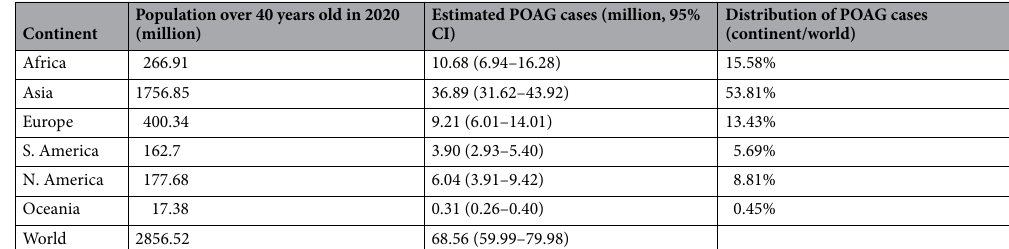
Table 2. Estimated global population of glaucoma. POAG primary open-angle glaucoma, S. America South America, N. America North